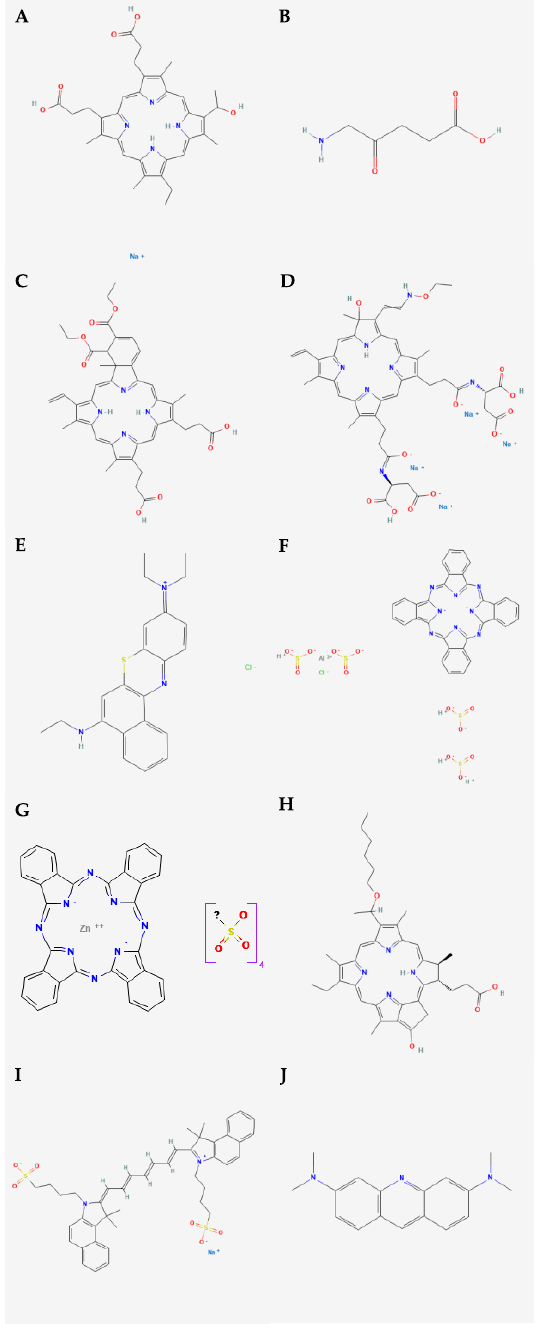
Figure 3. The main chemical structures of photosensitizers used in veterinary neoplasms. Structures retrieved from PubChem Compound. ( A ) Chemical structure of hematoporphyrin ether (CID 3086257). The molecule depicted constitutes the purified component of the hematoporphyrin derivative, a mixture of oligomeric porphyrins. ( B ) 5-aminolevulinic acid, 5-ALA (CID 137). ( C ) Benzoporphyrin derivative monoacid ring A, BDP-MA (CID 9896625). ( D ) 13,17-bis (1-carboxypropion) car-bam-oylethyl-3-ethenyl-8-ethoxyiminoethylidene-7-hydroxy-2,7,12,18-tetramethyl-porphyrin sodium, PAD-S31 (CID 136700393). ( E ) 5-ethylamino-9-diethylaminobenzo(a)phenothiazinium